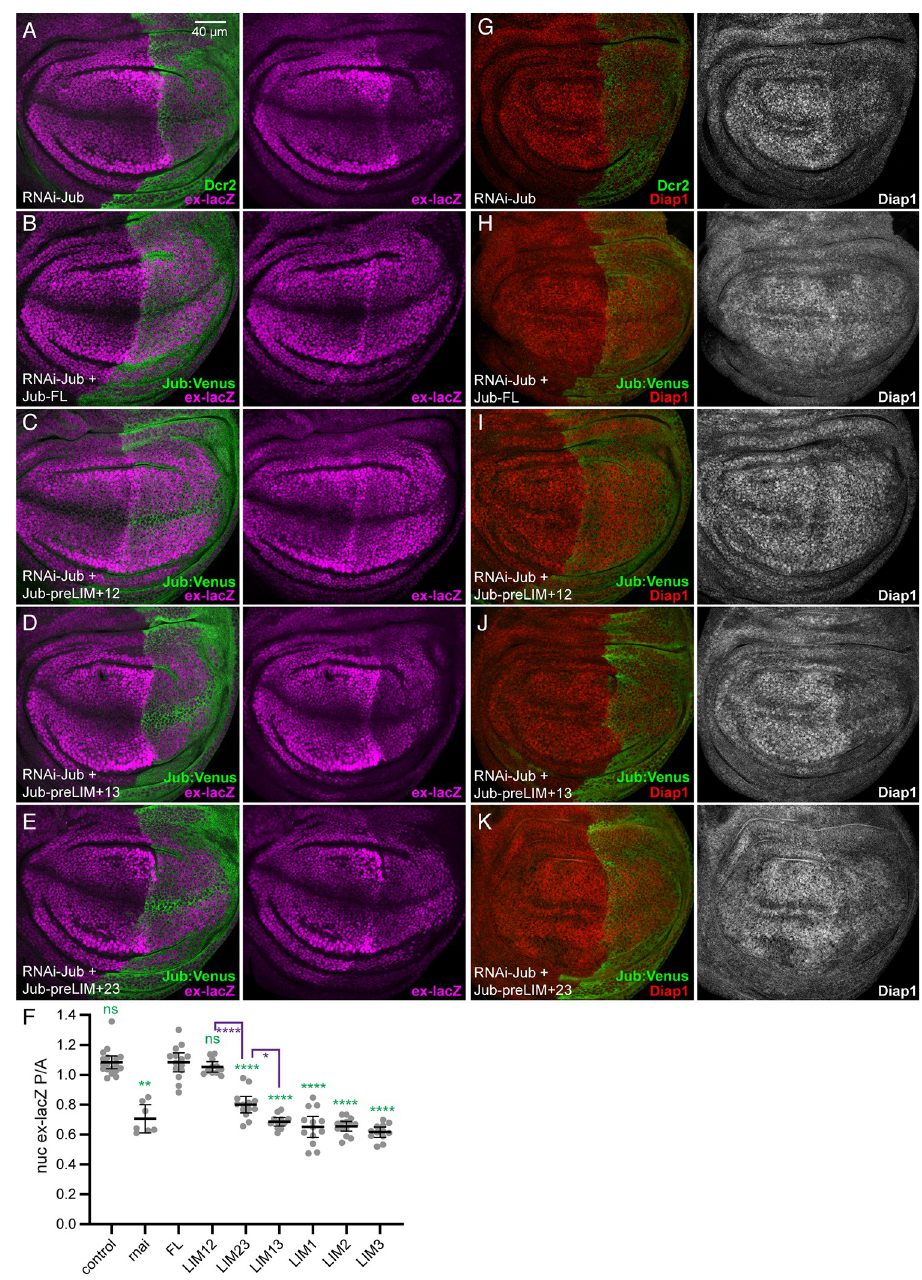
Fig 3. Rescue of Yki target gene expression by Jub deletion constructs. A-E) Representative wing discs from larvae expressing ex-lacZ (magenta), hh-Gal4 UAS-Dcr2 and A) UAS-RNAi-jub . B) UAS-RNAi-jub UAS-Jub-FL : msVenus . C) UAS-RNAi-jub UAS-Jub-preLIM+12 : msVenus . D) UAS-RNAi jub UAS-Jub-preLIM+13 : msVenus . E) UAS-RNAi jub UAS-Jub-preLIM+23 : msVenus . All discs are shown at the same magnification (scale bar = 40 μ m). F) Scatter plot showing quantitation of ex-lacZ levels in the posterior wing pouch as compared to the levels in the anterior wing pouch, with mean and 95% ci indicated by black bars. Genotypes are indicated by abbreviations at bottom. Representative examples of ex-lacZ expression in control wing discs and wing discs from animals expressing single LIM domain Jub constructs are in S2 Fig. Numbers of wing discs measured is control) 18, jub RNAi) 7, Jub-FL ) 14, Jub-preLIM+12 ) 11, Jub-preLIM+23 ) 13, Jub-preLIM+13 ) 12, Jub-preLIM+1 ) 13, Jub-preLIM+2 ) 14, Jub-preLIM+3 ) 12. The significance of differences in expression levels as compared to UAS-RNAi-jub UAS-Jub-FL : msVenus are indicated by green asterisks, additional selected comparisons are in purple. G-K) Representative wing discs stained for Diap1 (red/white) from larvae expressing hh-Gal4 UAS-Dcr2 and A) UAS-RNAi-jub . B) UAS-RNAi-jub UAS-Jub-FL : msVenus . C) UAS-RNAi-jub UAS-Jub-preLIM+12 : msVenus . D) UAS-RNAi jub UAS-Jub-preLIM+13 : msVenus . E) UAS-RNAi jub UAS-Jub-preLIM+23 : msVenus . All discs are shown at the same magnification as for ex-lacZ stains.